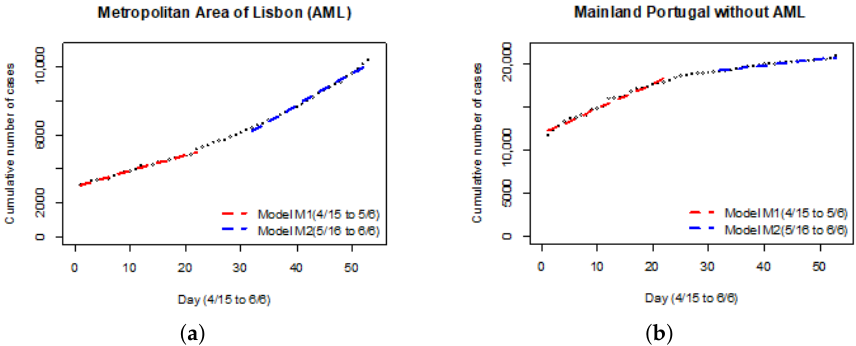
Figure 3. Linear models fit to the S 1 and S 3 time series in ( a ) AML and ( b ) the rest of mainland Portugal. The slope homogeneity hypothesis was rejected, with a significance level of 5%, by applying an ANCOVA test ( p -value < 2.2 × 10 − 16 ).